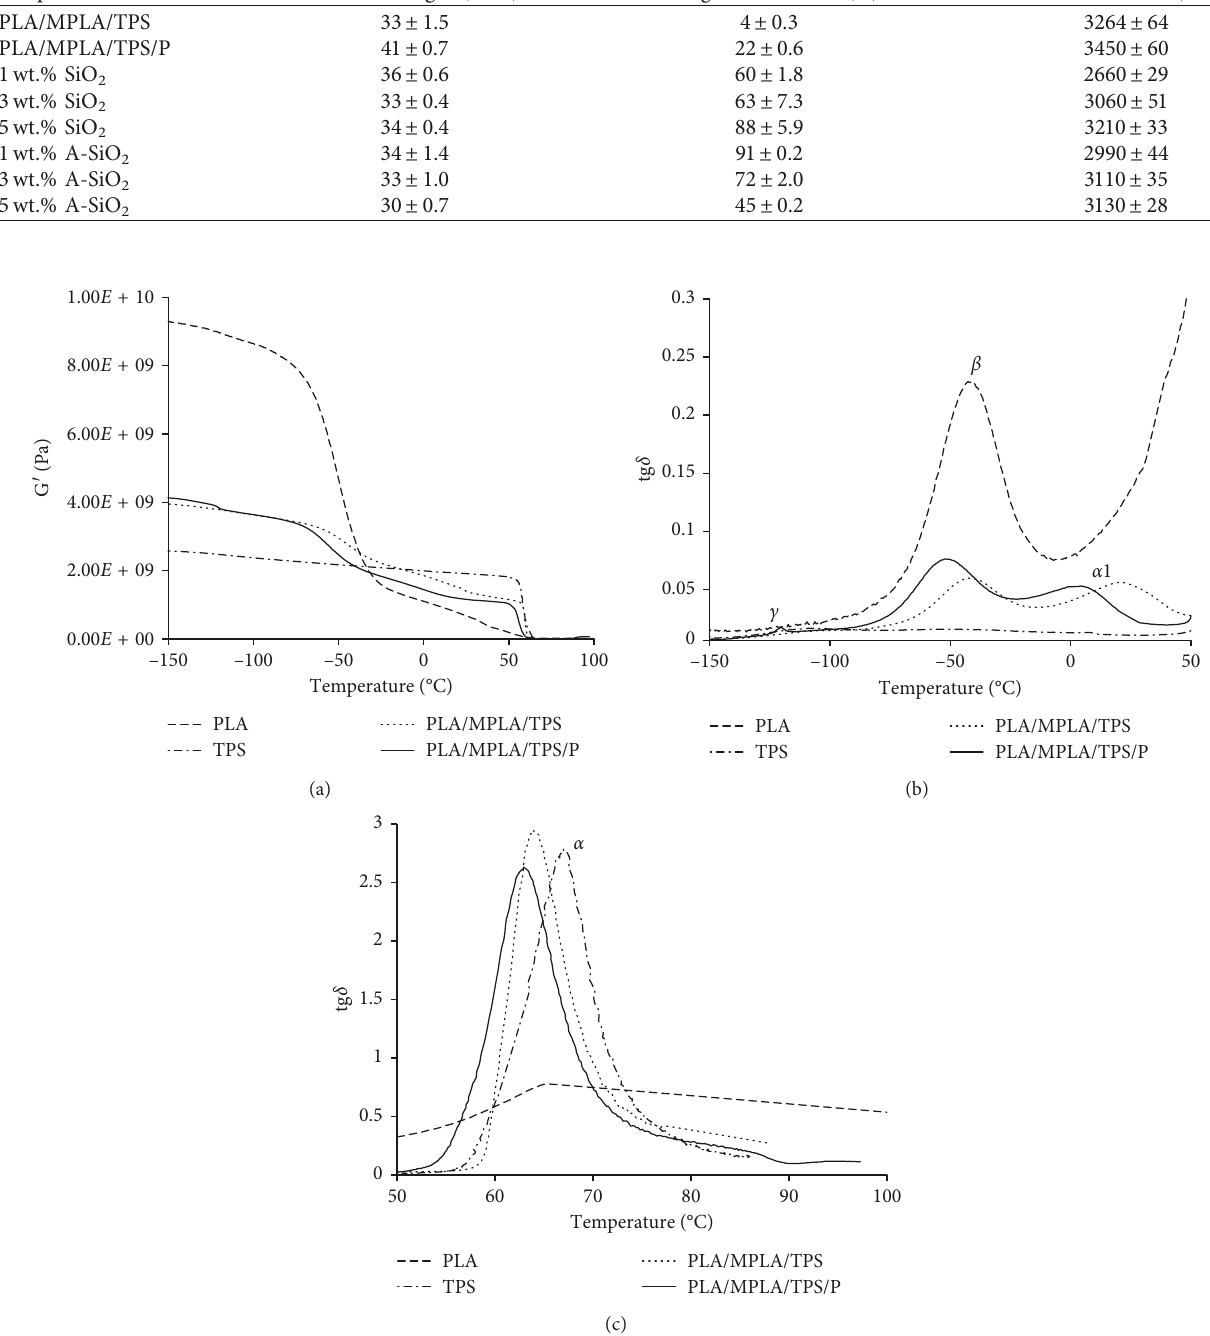
Figure 10: Dependence of G ′ and tg δ of PLA, TPS, and various blends on